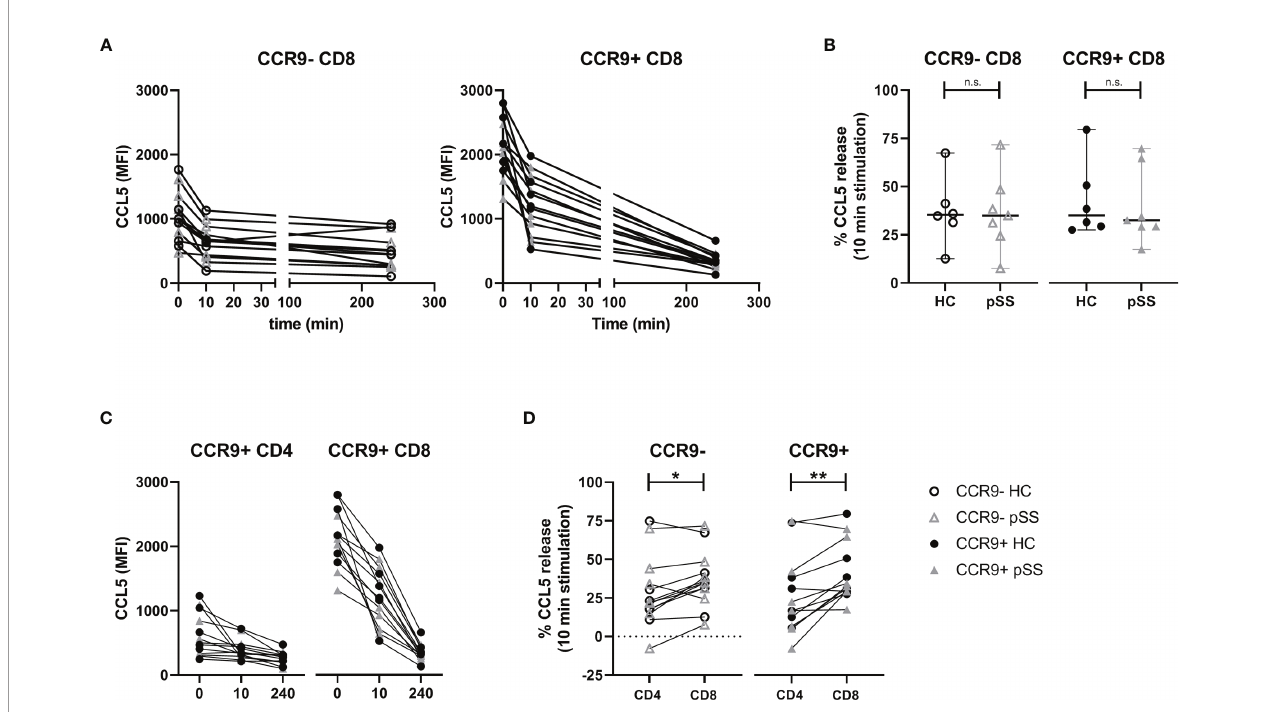
FIGURE 4 | Rapid relative but not absolute CCL5 release is comparable between HC and pSS. CCR9+ CD8 T cells release more CCL5 than CCR9+ CD4 T cells. For n=6 HC and n=7 pSS the MFI CCL5 was determined at t=0, t=10 minutes and t=4 hours. (A) Graphs showing MFI CCL5 over time for both CCR9- and CCR9+ CD8 T cells. (B) Comparison of CCL5 release after 10 minutes stimulation with phorbol myristate acetate (PMA) and ionomycin between HC and pSS patients in CCR9- and CCR9+ CD8 T cells. (C) Graphs depicting timepoints t=0, t=10m and t=4h (unscaled) for CCR9+ CD4 T cells and CCR9+ CD8 T cells combining HC and pSS patients. (D) difference between CD4 and CD8 T cells in CCL5 release after 10 minutes stimulation for CCR9- and CCR9+ cells. MFI, mean fl uorescence intensity; pSS, primary Sjögren ’ s syndrome; HC, healthy controls; n.s., not signi fi cant. *, **, indicates statistical signi fi cance of p<0.05, 0.01,